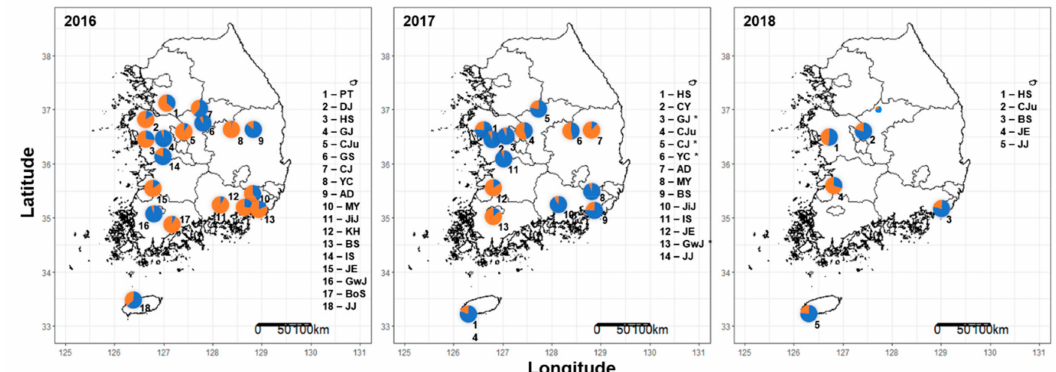
Figure 3. All populations partitioned in two clusters ( K = 2) and the pie graphs revealing the results from a Bayesian cluster analysis of multilocus genotypes in 2016, 2017, and 2018. The population identifiers (IDs) are indicated in pie graphs (* = samples collected from field pepper).